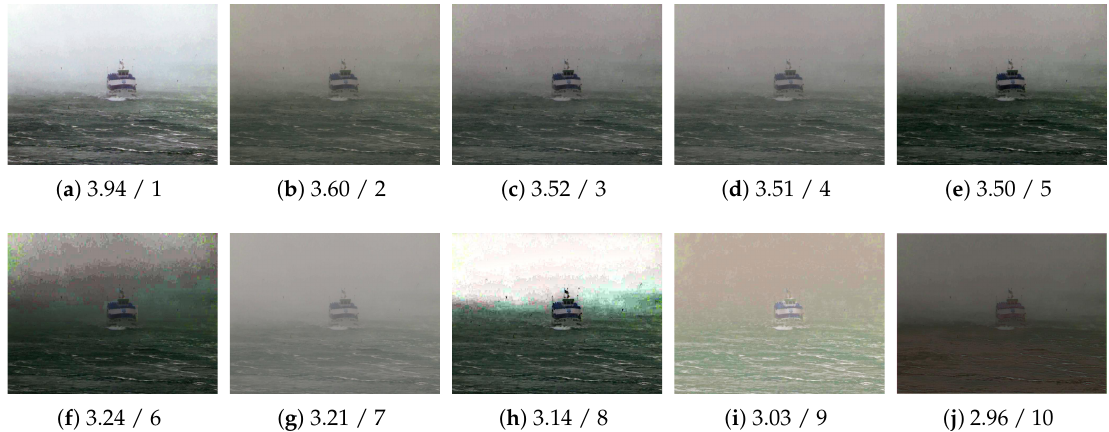
Figure 11. Comparison via the proposed IQA model. Ranking scores and the rankings are shown below each image. ( a ) Ours. ( b ) CAP. ( c ) MSCNN. ( d ) DehazeNet. ( e ) Proximal. ( f) DCP. ( g ) Input. ( h ) BCCR. ( i ) FVR. ( j ) AOD-Net.